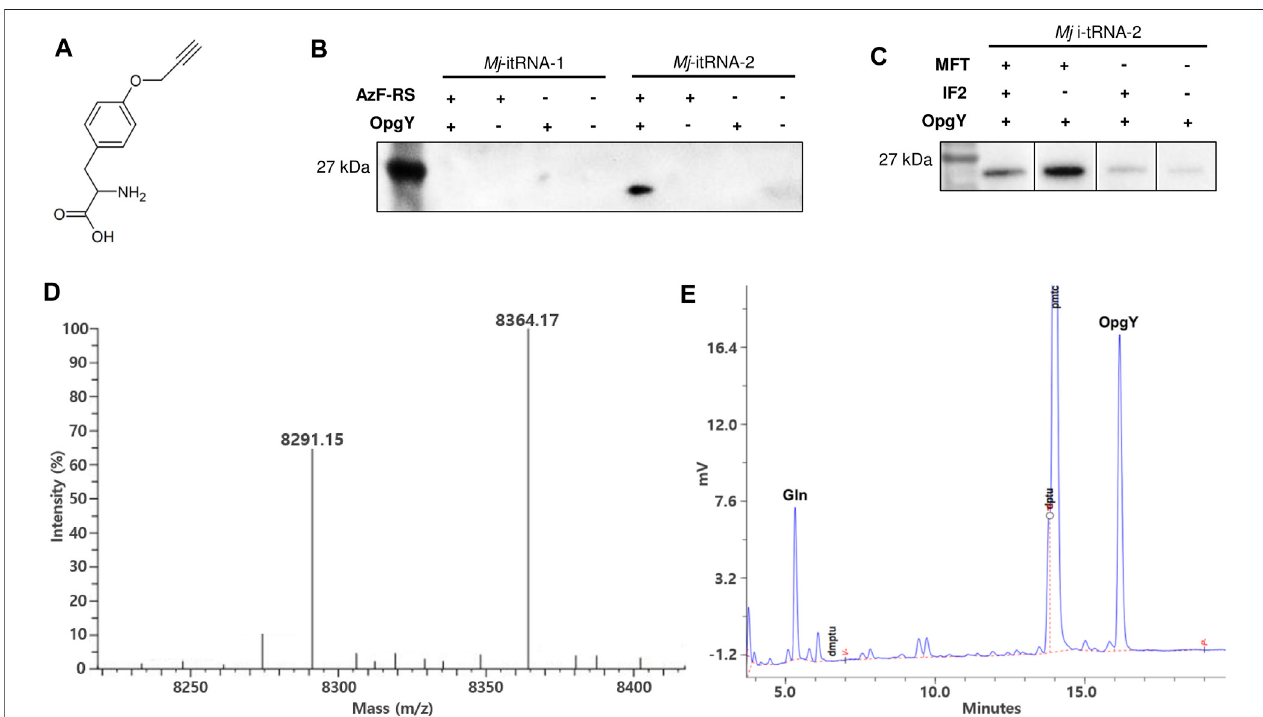
FIGURE3| Incorporationofnon-canonicalaminoacidsintothetranslationinitiationposition. (A) O-propargyl-l-tyrosine(OpgY). (B) Comparisonof Mj -itRNA-1and Mj -itRNA-2 for the OpgY incorporation into the TAG codon located at the N-terminus of GFP. (C) Effects of additional expression of E. coli methionyl-tRNA transformylase (MTF) or E. coli initiation factor-2 (IF-2) on the protein synthesis initiation at the TAG codon. Each cell lysate was subjected to the Cu(I)-catalyzed click reactionwith biotin-azide, and then theblot wasprobed with astreptavidin-horse radish peroxidase (HRP) conjugate (B, C) .The uncropped raw datawere shown in Supplementary Figures S2B, S2C . (D) Deconvoluted electrospray ionization mass spectrum of the puri fi ed Z domain. The protein has the TAG codon at the translation initiation position. The calculated mass when OpgY is incorporated into the TAG codon is 8,364.06 Da, and that with Gln is 8,290.96 Da. (E) Edman sequencing result for the fi rst residue of the puri fi ed Z domain expressed with OpgY. The results for the second to the fi fth residue are shown in Supplementary Figure S4